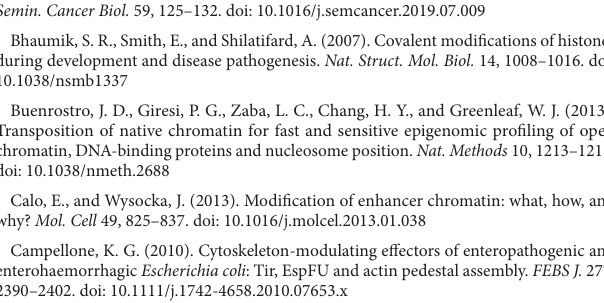
SUPPLEMENTARY TABLE S2 Metadata and mapping statistics for RNA-seq and ATAC-seq. SUPPLEMENTARY TABLE S3 Pathways enriched by GSEA analysis between E. coli F18ac and control groups. SUPPLEMENTARY TABLE S4 Pathways enriched by GSEA analysis between E. coli F18ac with and without L. reuteri